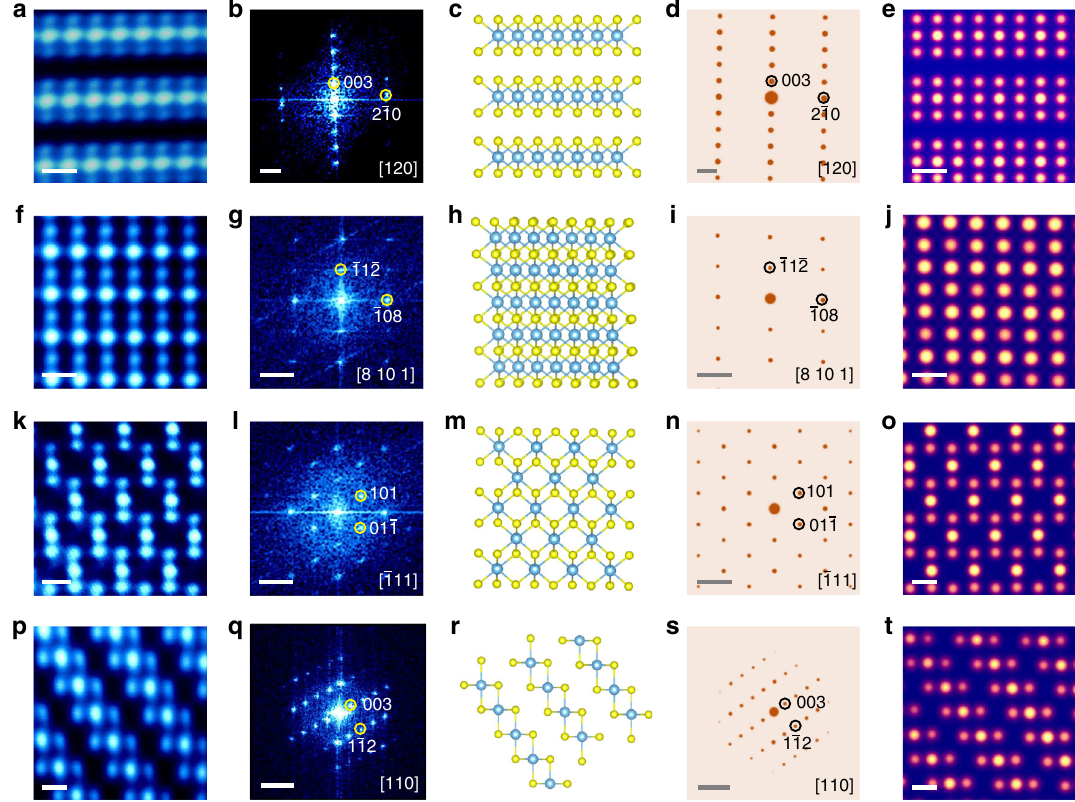
Fig. 2 The atomic structure of PbI 2 along different zone axes. a , f , k , p STEM images of PbI 2 along [120], [8 10 1], [ (cid:1) 111], and [110] zone axes with b , g , l , q the corresponding FFT patterns, c , h , m , r atomic ball-and-stick models, d , i , n , s simulated ED patterns, and e , j , o , t simulated STEM images. Scale bar, 0.3 nm ( a , e , f , j , k , o , p , t ); 2 nm − 1 ( b , d ); 3 nm − 1 ( g , i , l , n , q , s be fi tted by MAPbI 2.5 with ordered iodine vacancies as shown in Fig. 5j. Compared with the pristine MAPbI 3 in Fig. 5i, part of iodine ions on the (001) plane indicated by the black circles in Fig. 5j are lost to form the superstructure MAPbI 2.5 . The corresponding simulated ED pattern of MAPbI 2.5 in Fig. 5f